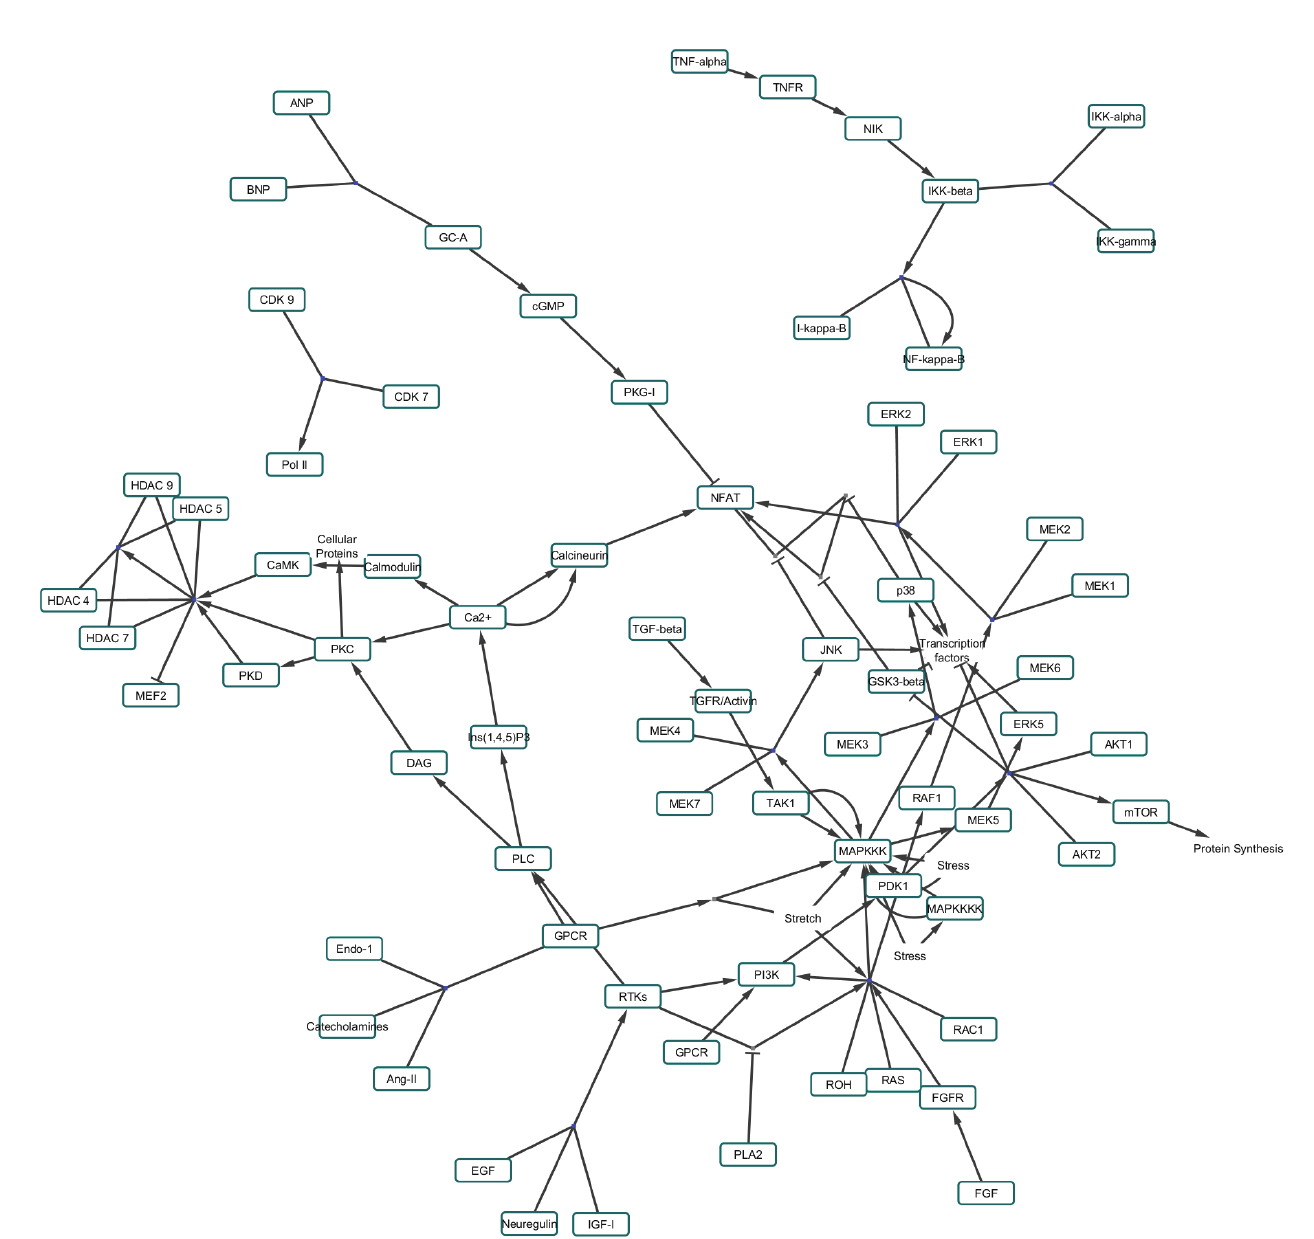
Supplementary Figure 2. Figure 2A in the WikiPathways App paper including all graphical details, e.g.